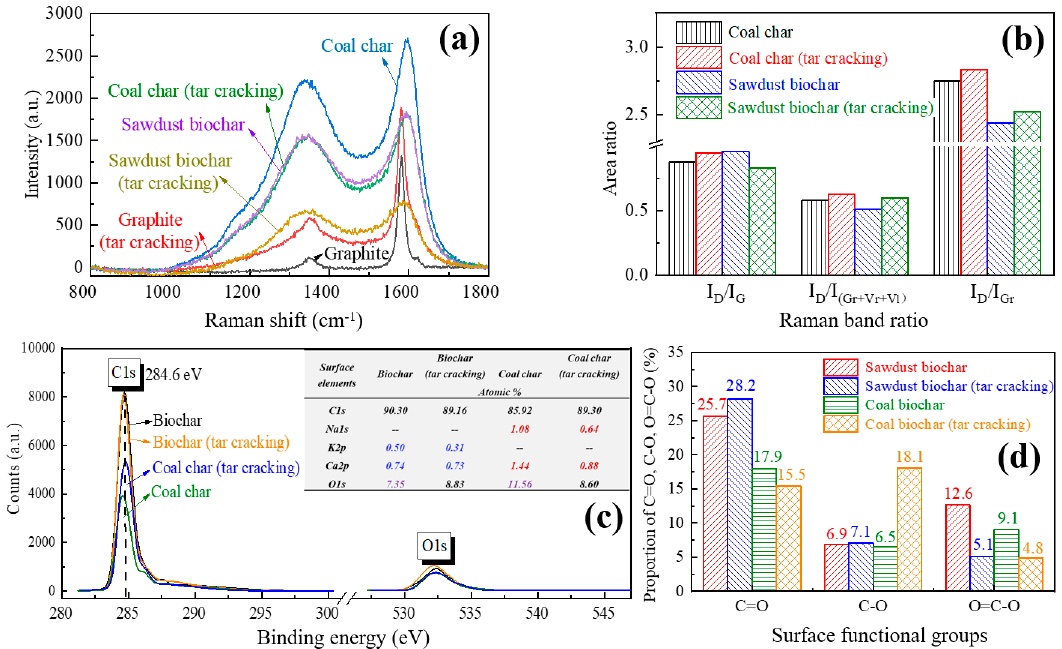
Figure 3. Chemical characteristics of char-based catalysts on in-situ biomass tar reforming: ( a ) Raman spectra; ( b ) Raman band ratio; ( c ) C1s and O1s peaks in XPS spectra; and ( d ) Proportion of C=O, C–O, O=C–O functional groups.